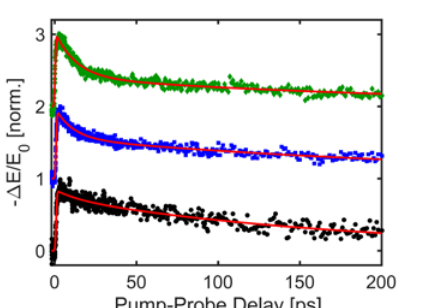
Figure 1 Normalized ∆ E/E signal at 160, 80 and 20 µ J/cm 2 (green diamonds, blue squares and black circle respectively) together with the biexponential curves (continuous red